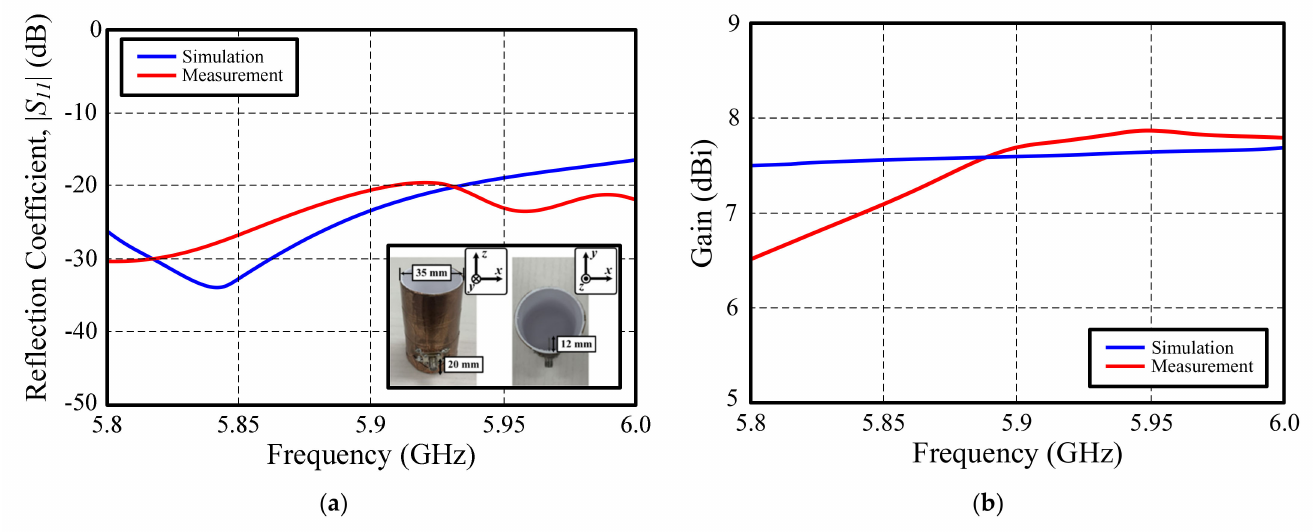
Figure 6. Designed circular horn antenna: ( a ) S -parameter and ( b ) antenna